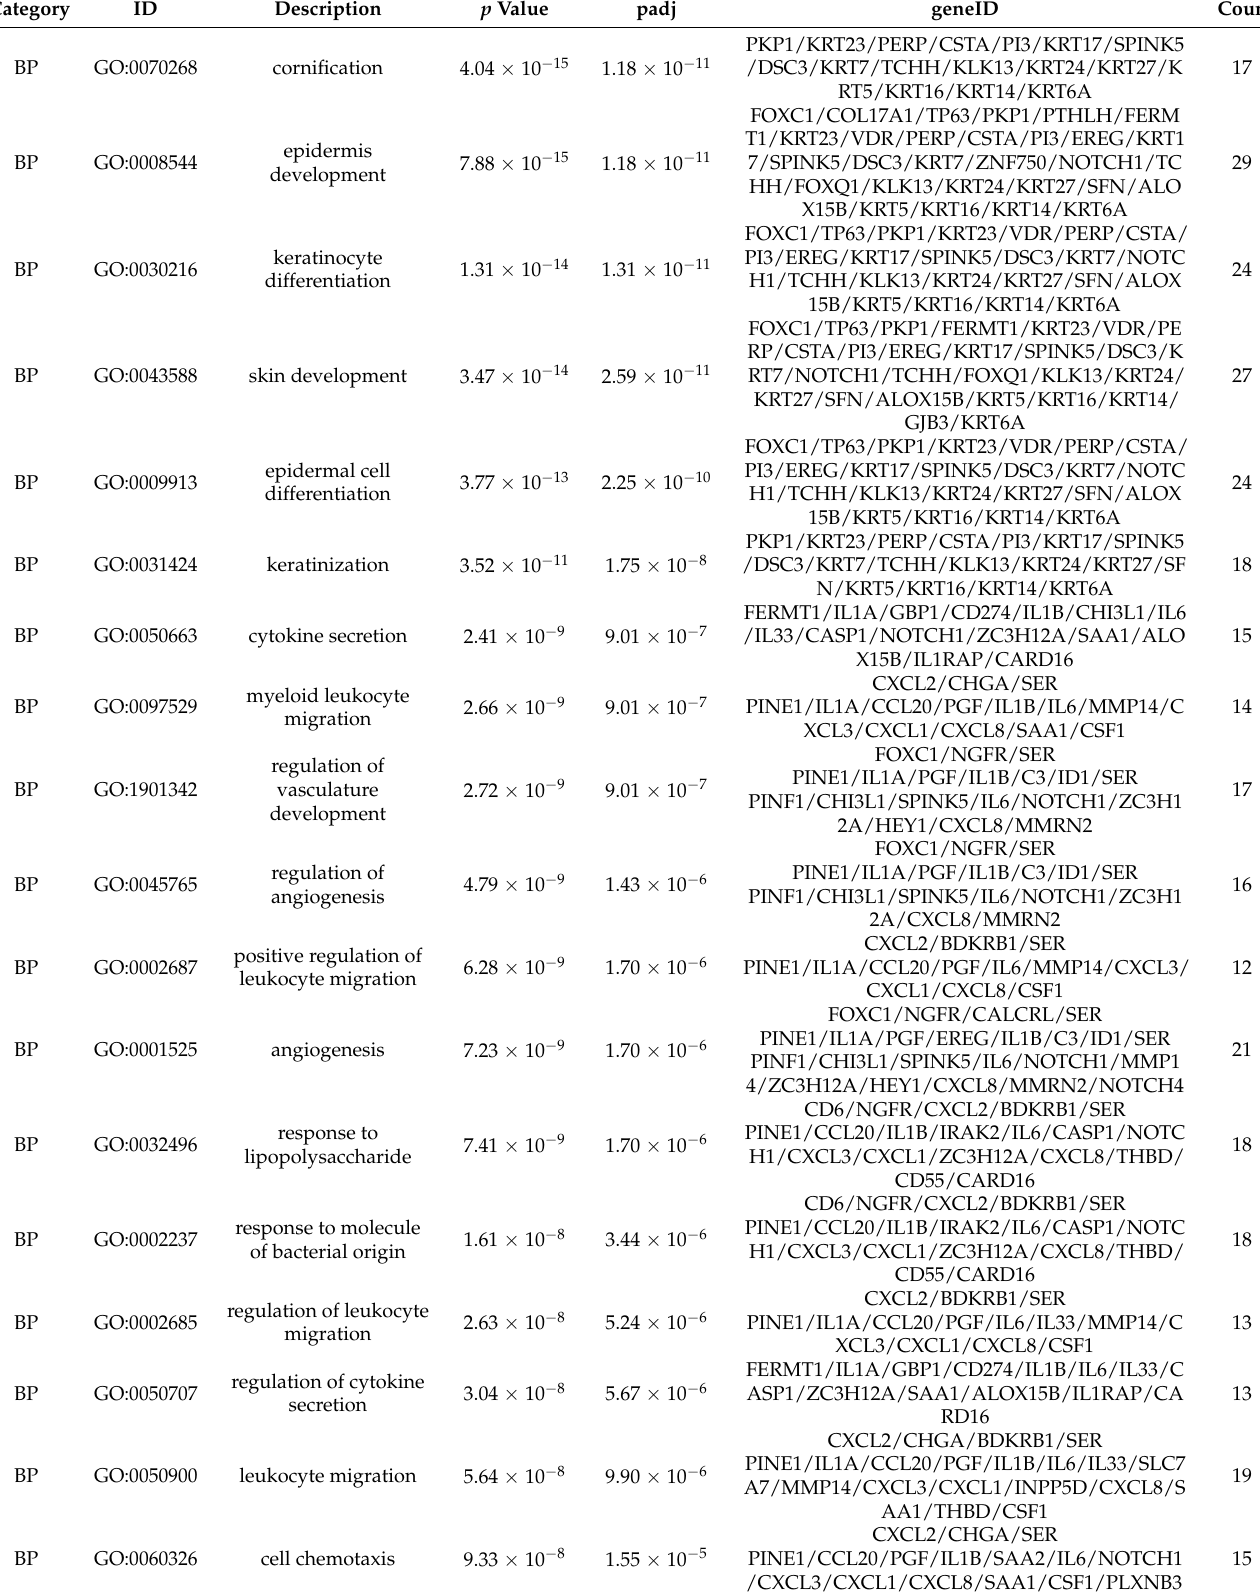
Table 1. The top 20 ranked GO gene